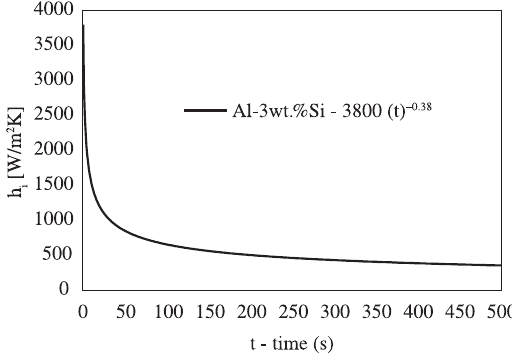
Figure 4. Evolution of the metal-mold interfacial heat transfer coefficient as a function of time.